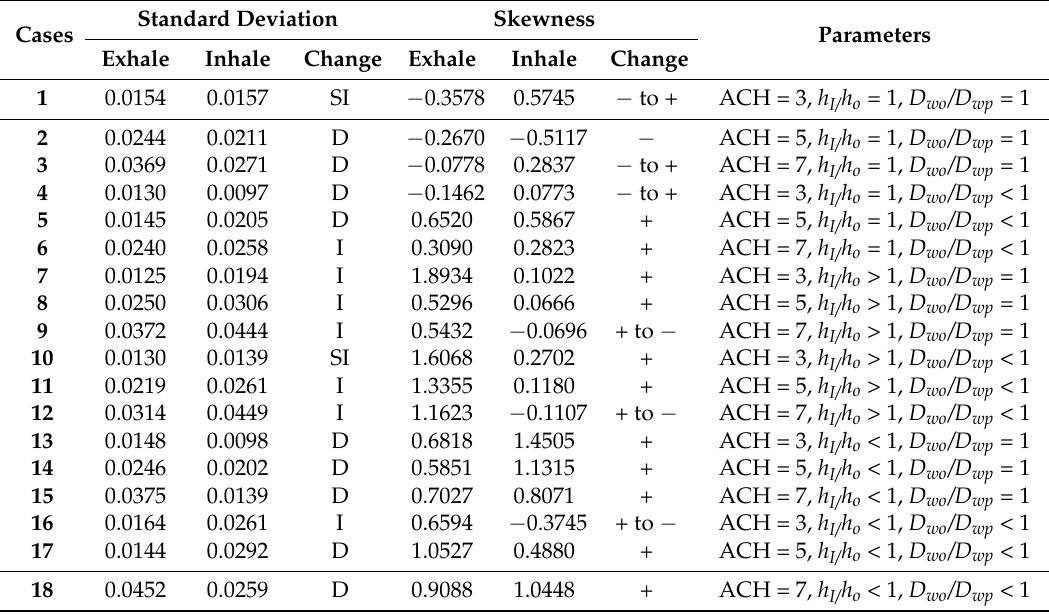
Table 2. Standard deviation and skewness to assess the changes from exhale to inhale